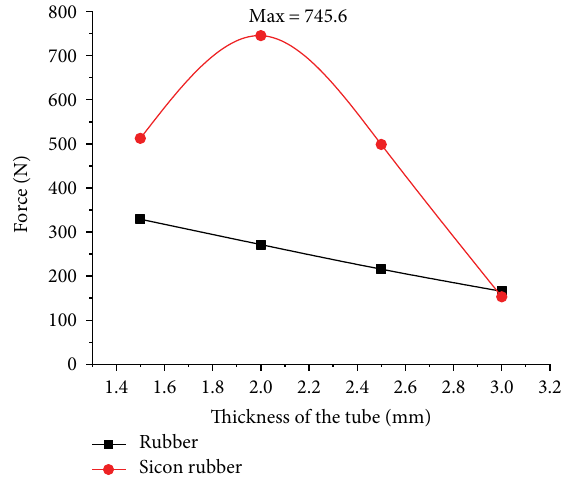
Figure 12: Force of the PAMs with different wall thicknesses and soft materials under the pressure of 0.3 MPa at contraction of 10%.